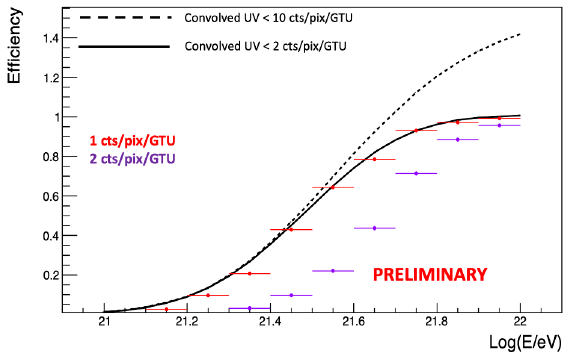
Figure 2. Trigger e ffi ciency curves of Mini-EUSO for ESAF simulated proton-generated EASs of di ff erent energies on dif- ferent background levels. The red and blue points assume a fixed nightglow background of 1 and 2 counts / pix / GTU, respec- tively. The black line represents the convolved trigger e ffi ciency curve in which each background level below 2 counts / pix / GTU is weighted for the relative fraction of time in which it was mea- sured by Mini-EUSO. The dotted line provides the fractional increase in exposure (relative to the black line) if the accepted nightglow background is increased from 2 counts / pix / GTU to 10 counts / pix / GTU. A significant increase in exposure is obtained only at the highest energies. See text for details.